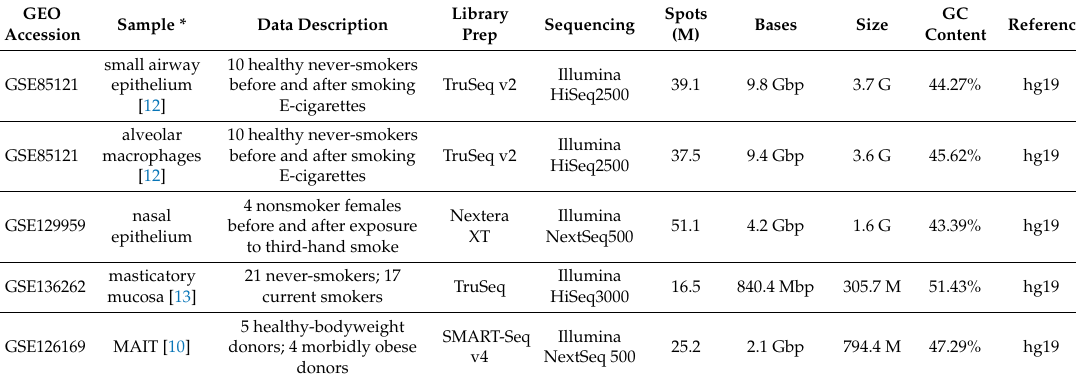
Table 1. Five datasets of RNAseq profiling analyzed in this